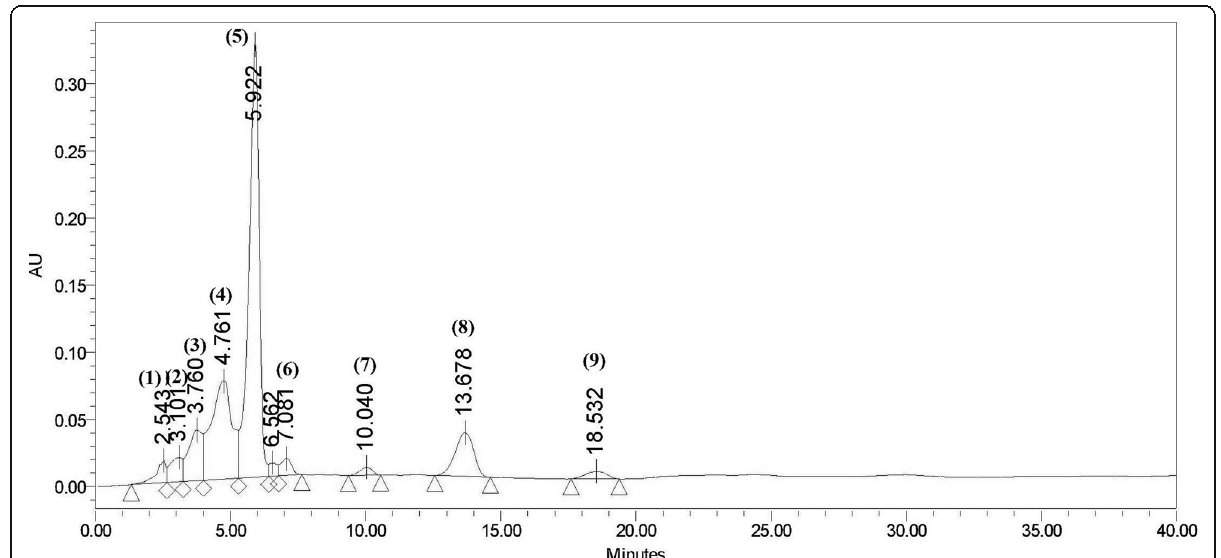
Fig. 4 HPLC chromatogram of chloroform extract of Andrographis paniculata whole